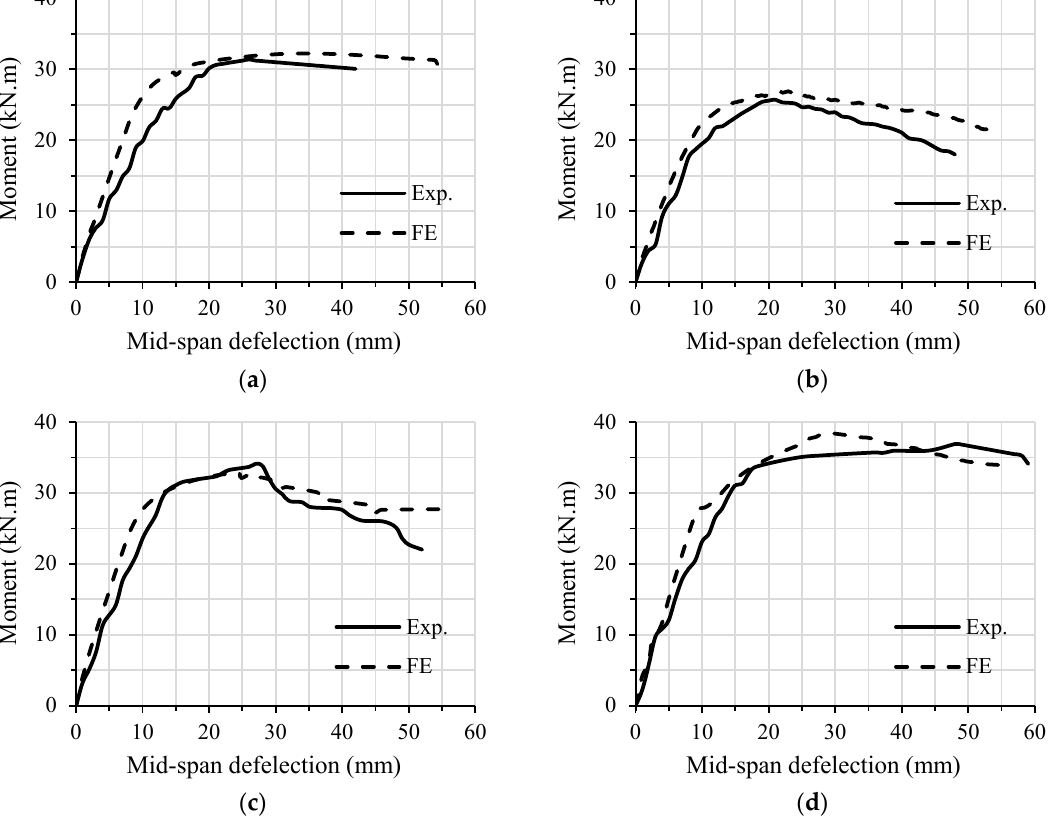
Figure 16. Moment–de fl ection curves of the FE models compared with the experimental results.